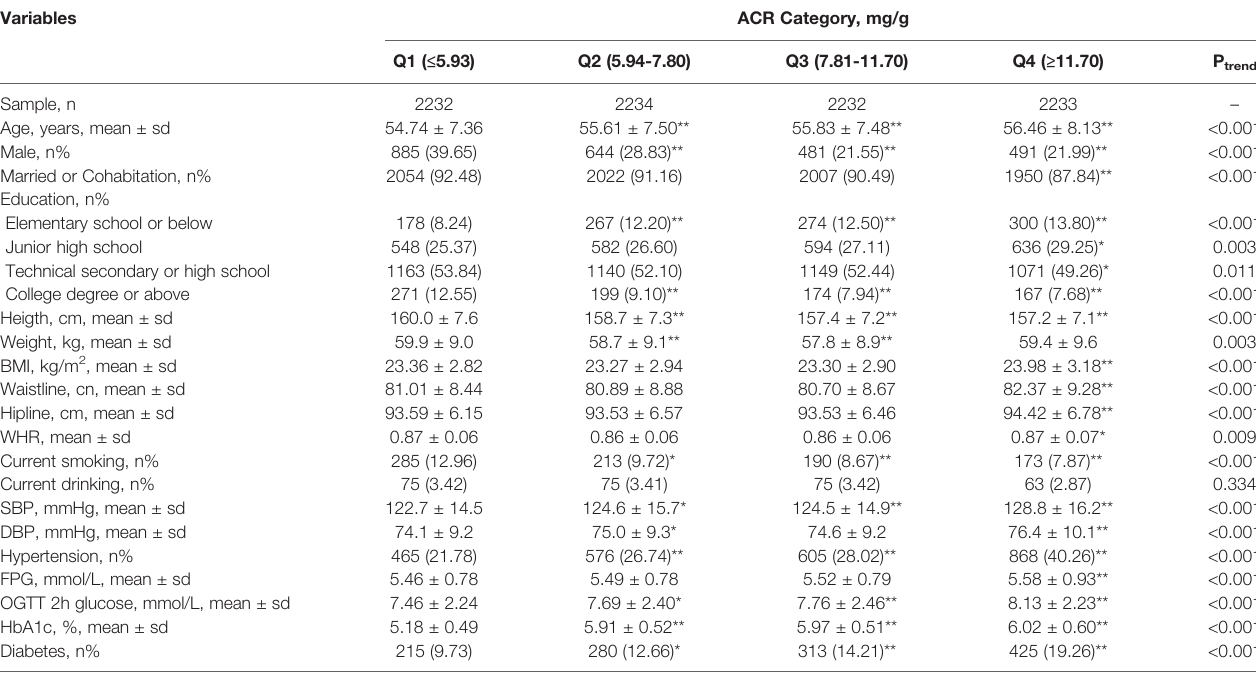
TABLE 1 | Characteristics of participants by ACR